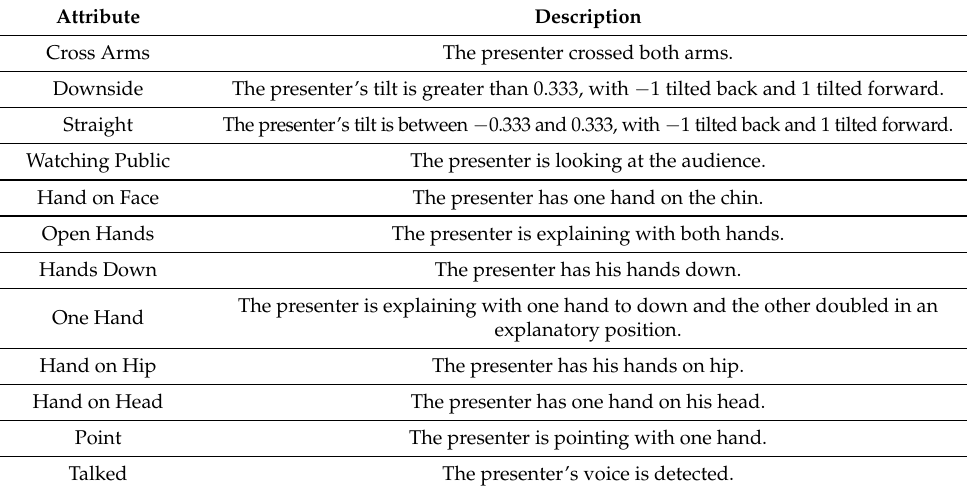
Table 2. Description of each database attribute.